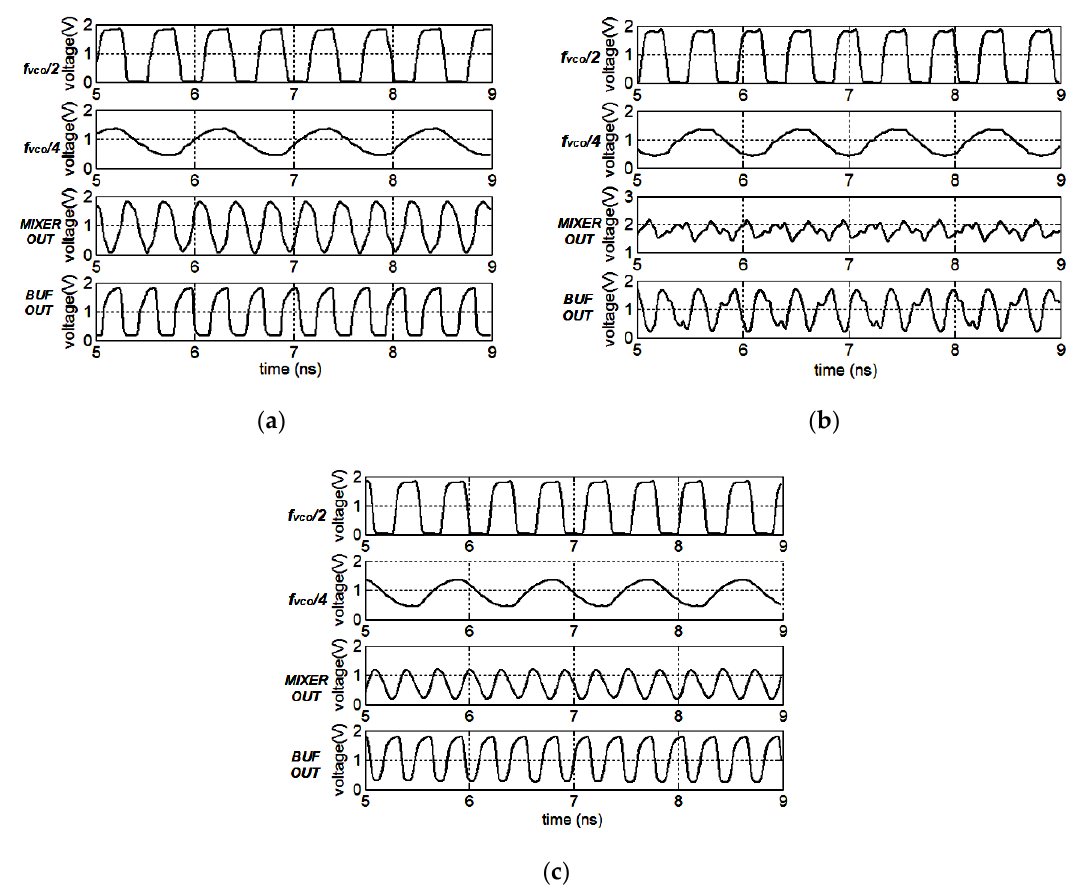
Figure 10. The transient simulation results of the QSSB mixer employing: ( a ) the Q-enhanced LC resonant load; ( b ) the conventional LC resonant load; ( c ) the proposed load.